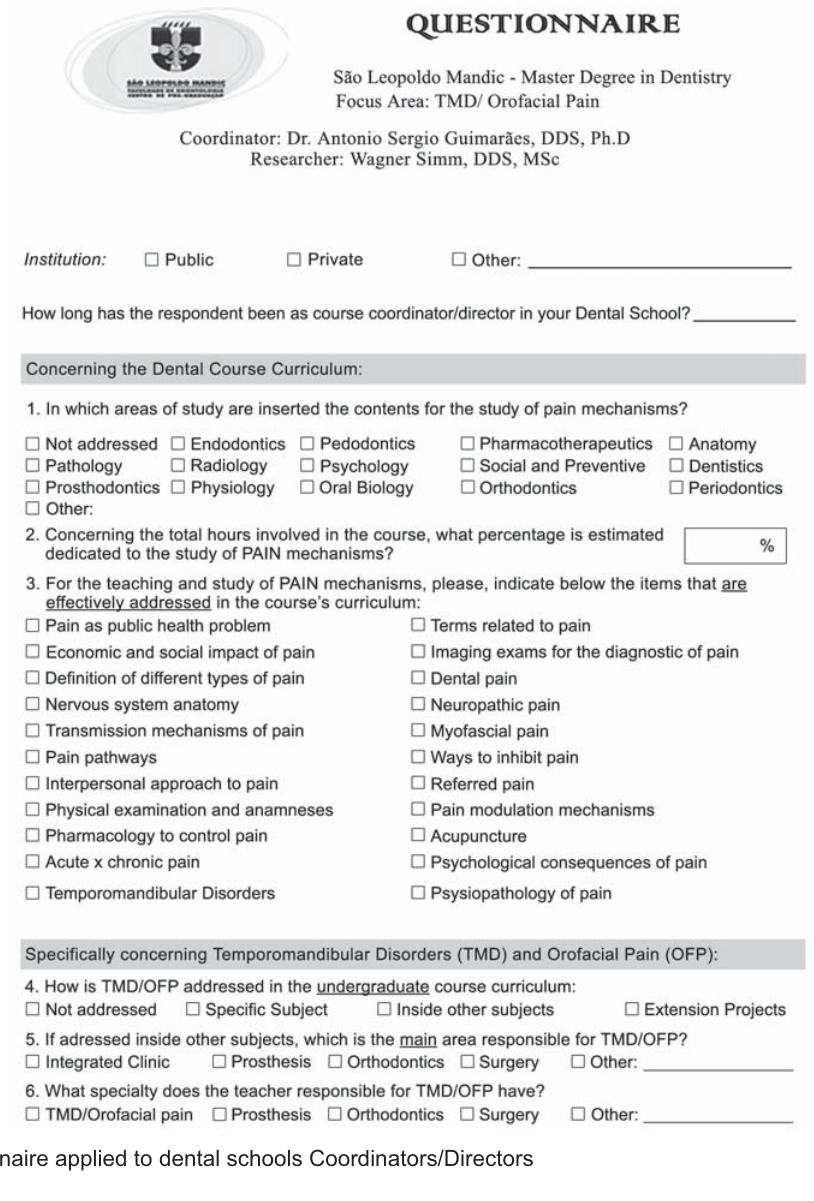
Table 1- Estimated time dedicated to the study of pain mechanisms in dental schools in